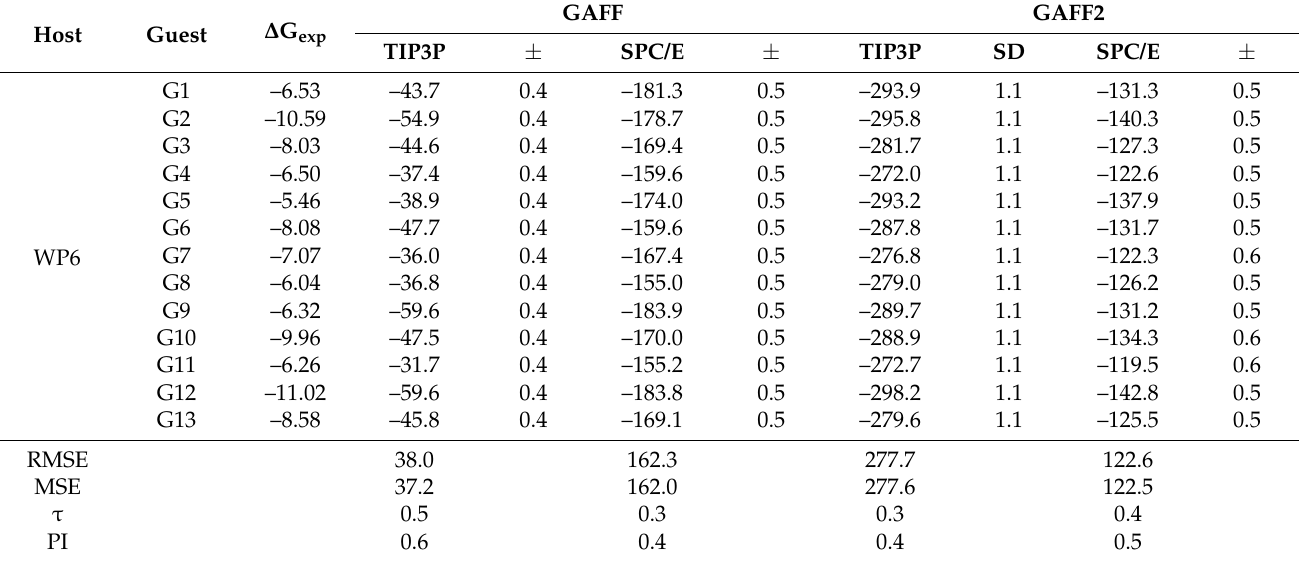
Table 3. Three-trajectory MM/PBSA end-point estimates. MSE, RMSE, τ , and PI serve as quality measurements. The detailed components of free energy contributions are presented in the support-